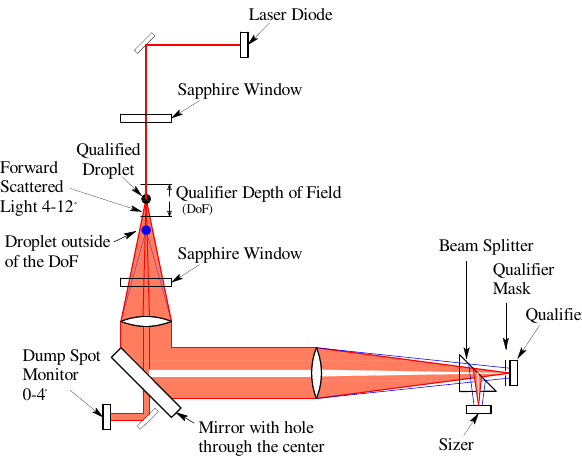
Fig. 1. Optical schematic of the CDP. Light rays colored in red indicate the scattering signal for a droplet within the qualifier DoF, whereas blue light rays indicate a droplet outside of the qualifier DoF. For the qualified droplet, the scattered light is focused through the slit of the qualifier mask, allowing the qualifier signal to be great enough such that the particle is